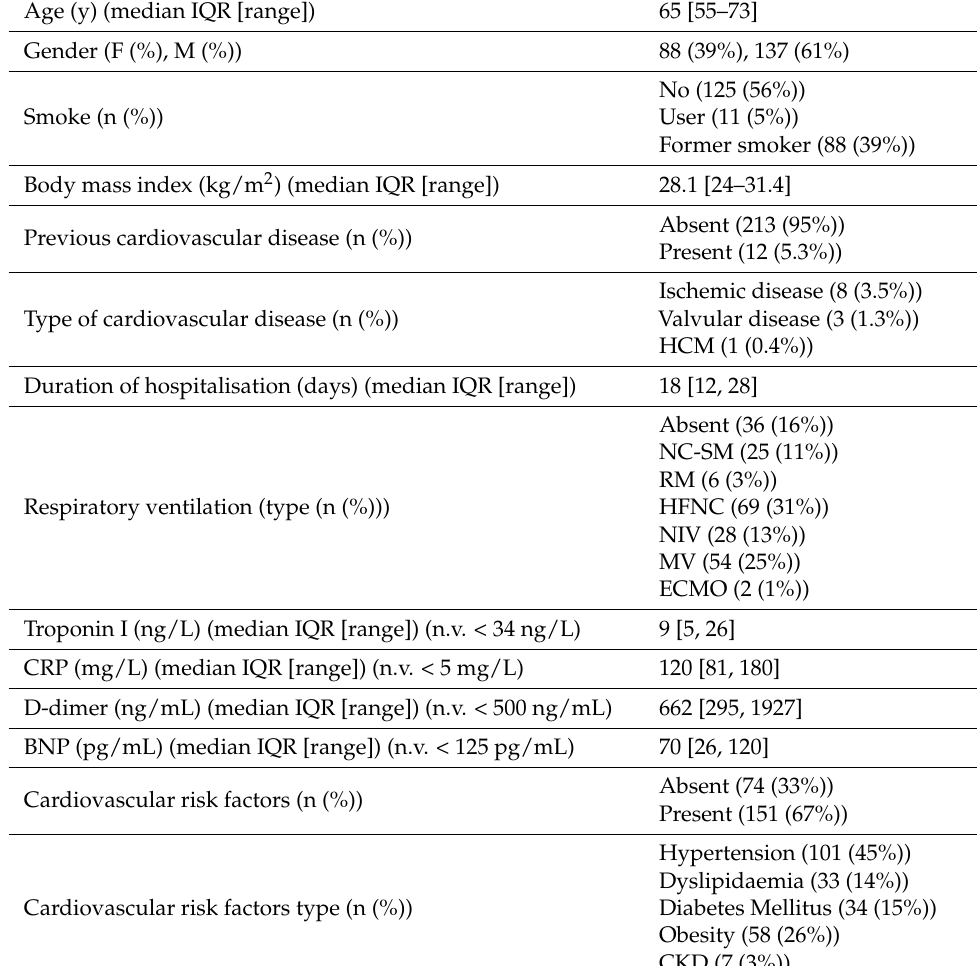
Table 1. Demographic and clinical characteristics at